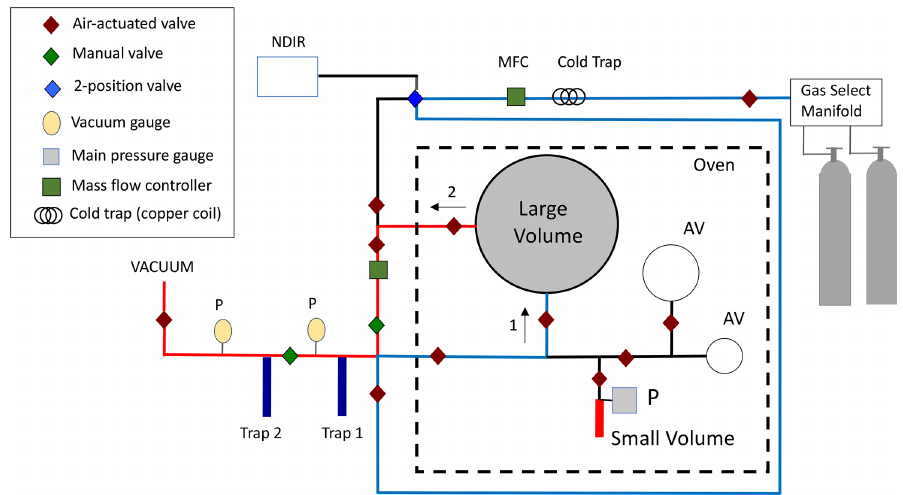
Figure 1. Schematic of the NOAA manometer. Air is passed through a cold trap ( ∼− 69 ◦ C) and mass flow controller into the large volume in the direction of arrow (1), which is shown as blue lines. After the temperature and pressure of the air in the large volume are recorded, the air is drawn from the large volume in the direction of arrow (2) (red lines) and through traps 1 and 2 to cryogenically trap the CO 2 . The CO 2 is cryogenically purified in glass traps 1 and 2 and then transferred to the small volume where its pressure and temperature are determined. Auxiliary volumes (AVs) are used in separate experiments to determine the ratio of large and small volumes (volume ratio). The dashed line depicts a temperature-controlled oven housing the glass volumes and pressure gauge.